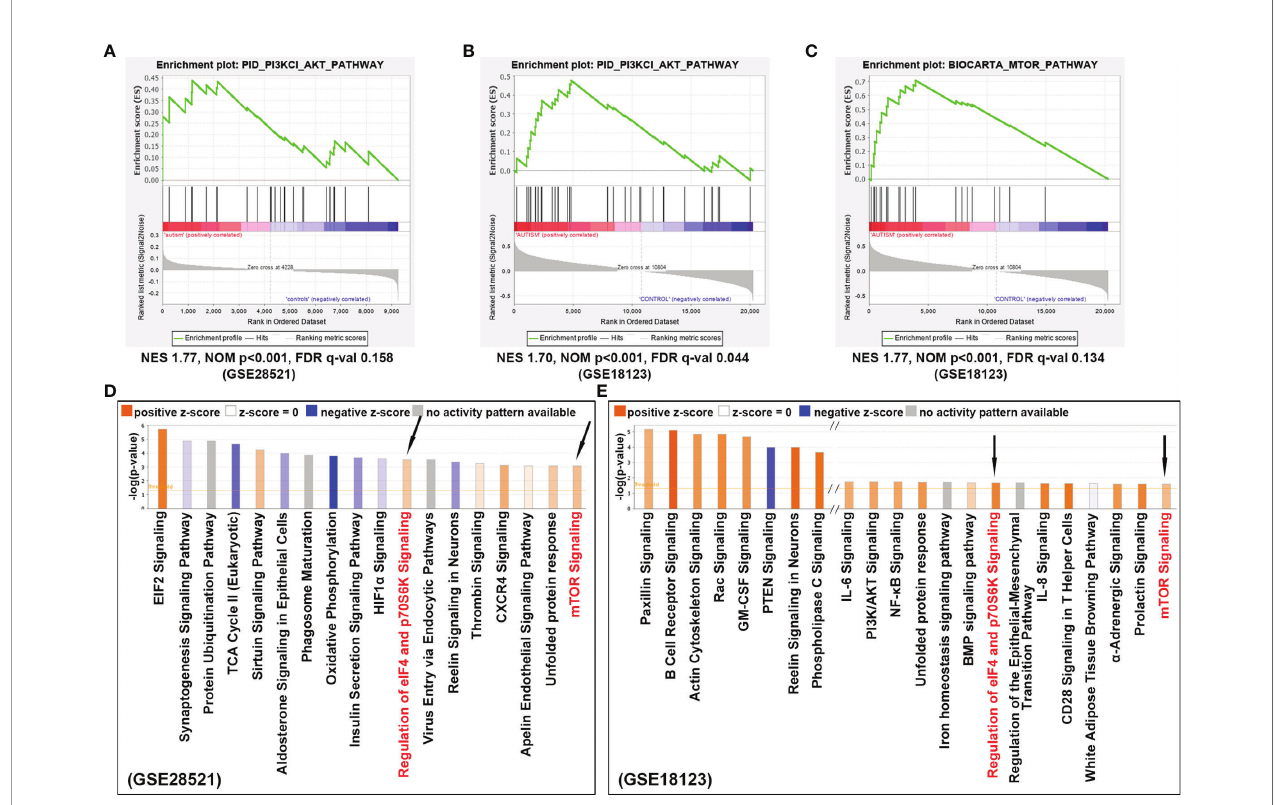
FIGURE 2 | Signaling pathways identi fi ed to confer ASD risk. (A) Enrichment analysis for dataset GSE28521 and (B) GSE18123, indicated that PI3K/AKT signaling pathway was positively correlated with ASD. (C) Enrichment analysis for dataset GSE18123, indicating that mTOR signaling was also positively correlated with ASD. (D) Canonical pathway analysis of the differentially expressed genes from dataset GSE28521, sorted by – log(p-value). (E) Canonical pathway analysis of the differentially expressed genes from dataset GSE18123, sorted by – log(p-value). Positive z-scores indicate the activation of the corresponding signaling pathways. Signaling pathways that can be enriched in both datasets are indicated by black arrows.